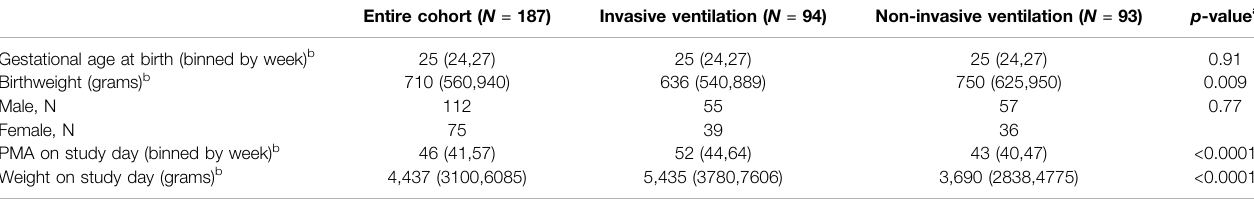
TABLE 1 | Entire cohort and ventilation group demographics.